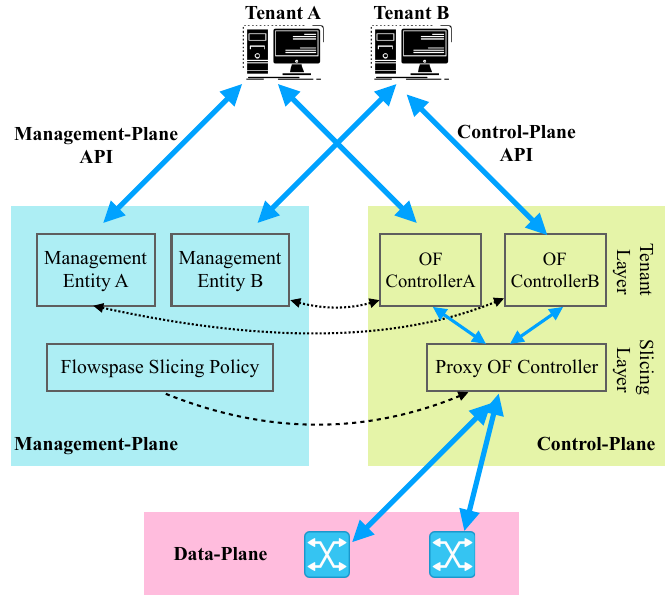
Figure 4. Proxy Controller-based